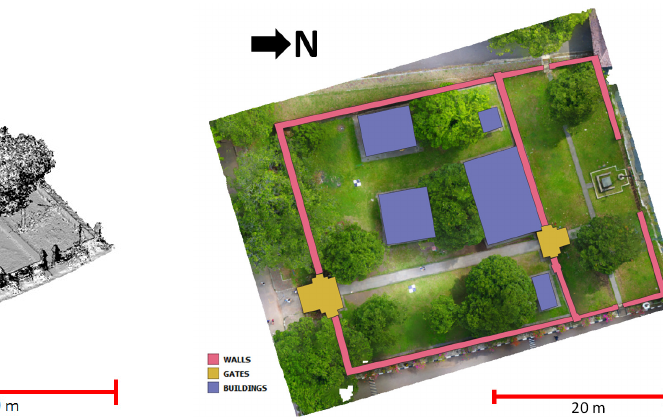
Figure 2. The unorganised and unclassified point cloud used as input for the algorithm.